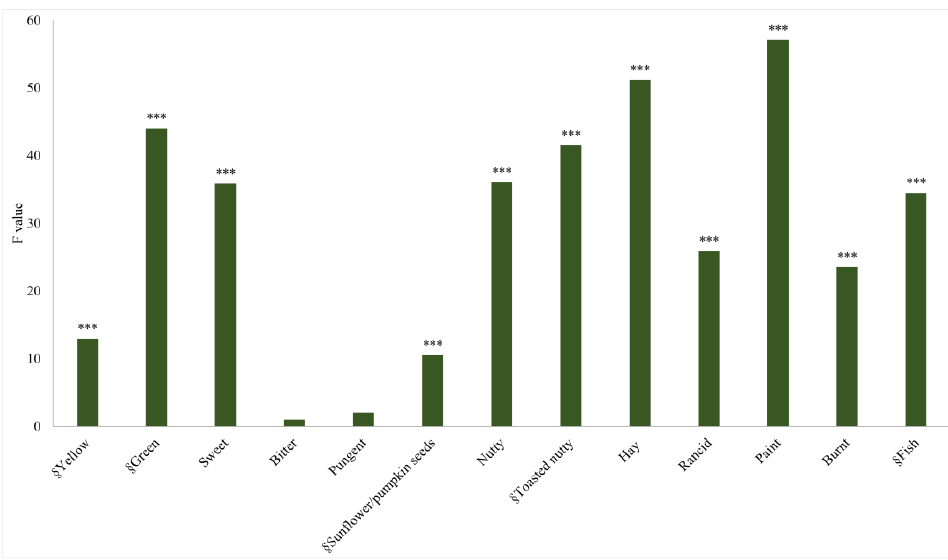
Figure 3. Three-way ANOVA on cold-pressed hemp seed oil (CP-HSO) intensity data: F-values of sample effect. Significance: *** indicates p < 0.001. § indicates that the F value was ×10 −1 .